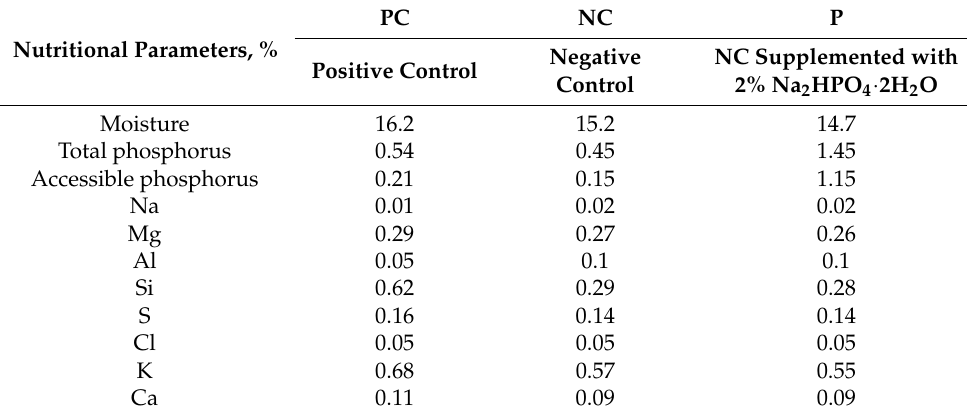
Table 1. Chemical composition of the diets used for feeding mice in the experimental groups. All values except moisture are normalised per dry